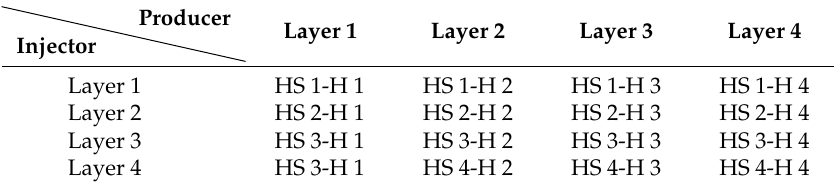
Table 6. Well pattern descriptions of the HS-H group.